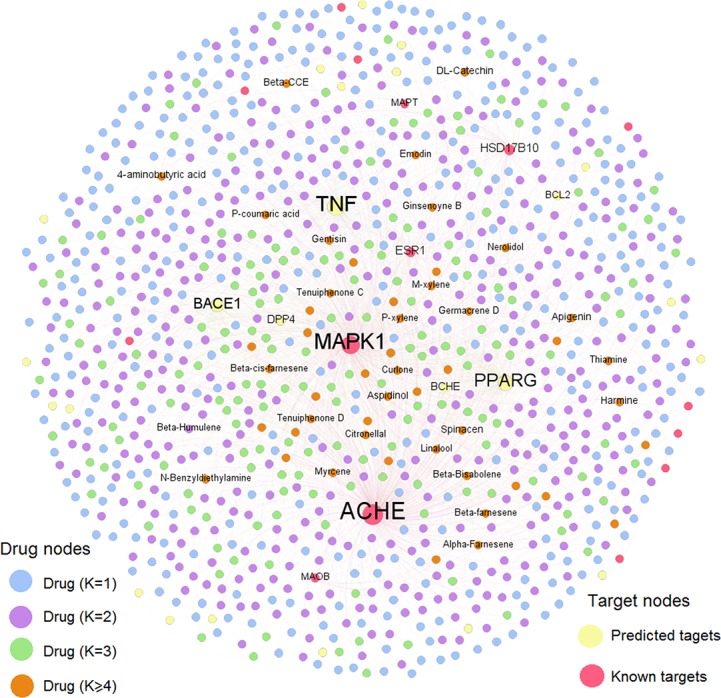
Global compound-target network of the candidate ingredients of Kai-Xin-San (KXS).